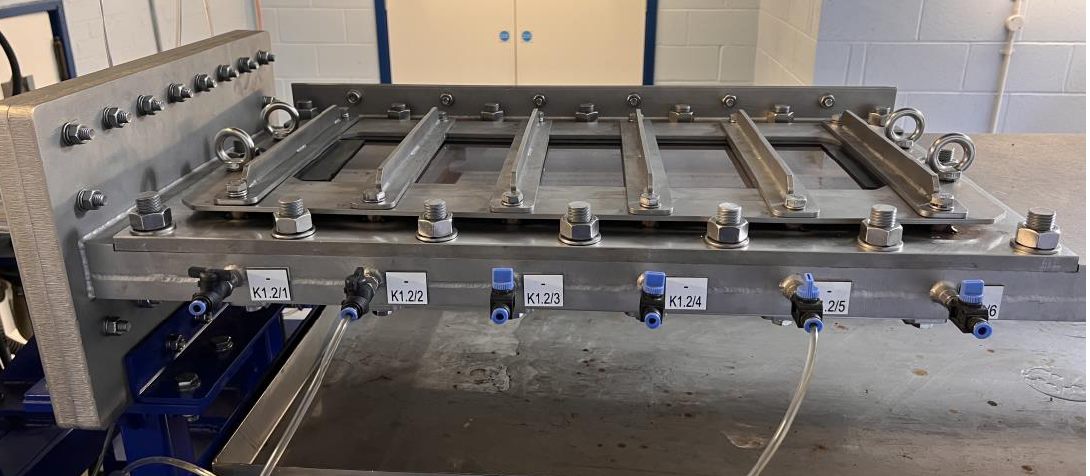
Figure 4. Pressure taps distribution numbered from 1 to 6 (left to right) on the test section of the FTFC.